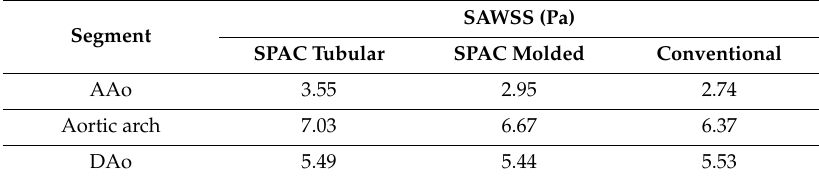
Table 5. The maximum and averaged secondary flow velocity of all designs at t 4 .